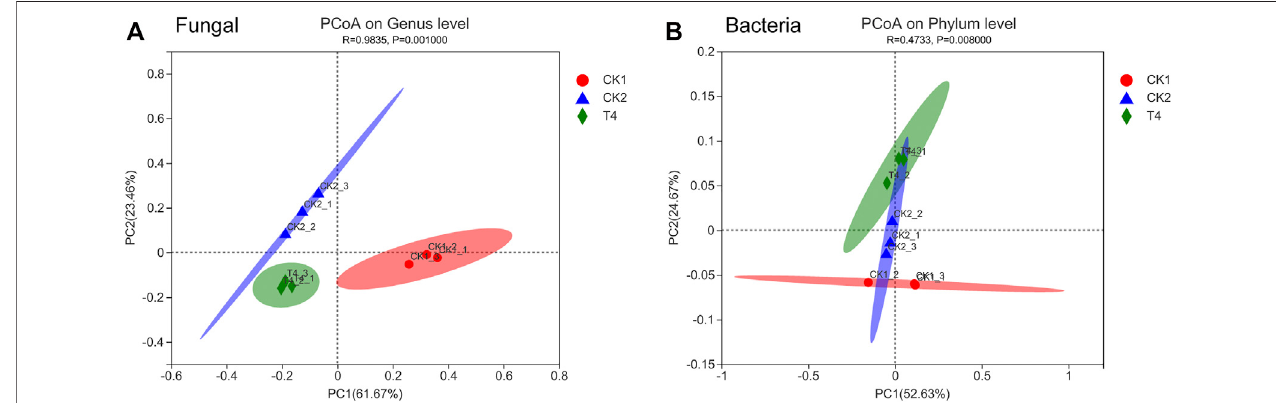
FIGURE6| AnalysisofbetadiversitybasedonGenuslevelofreplantsoilfungalandPhylumlevelofreplantsoilbacteria. (A) PCoAoffungiand (B) PCoAofbacteria. CK1:control,CK2:highstandardcontrol,T4:soilsoaking.Principalcoordinateanalysis(PCoA)wasbasedontheBray-Curtisdistancemetricatthegenuslevel,andthe results aredisplayed asascatter diagram. Differentcolorsand shapesofpoints indicate differentsamplegroups. The proximity oftwosamplepoints ispositivelyrelated to the similarity of the species compositions of the two samples.